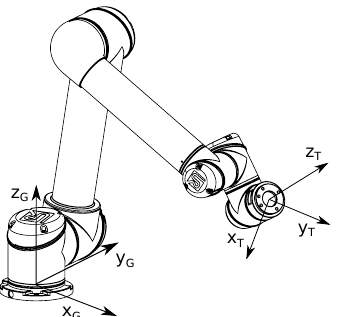
Figure 1. Kinematic structure of the Universal Robot UR5 manipulator—global reference frame and end-effector reference